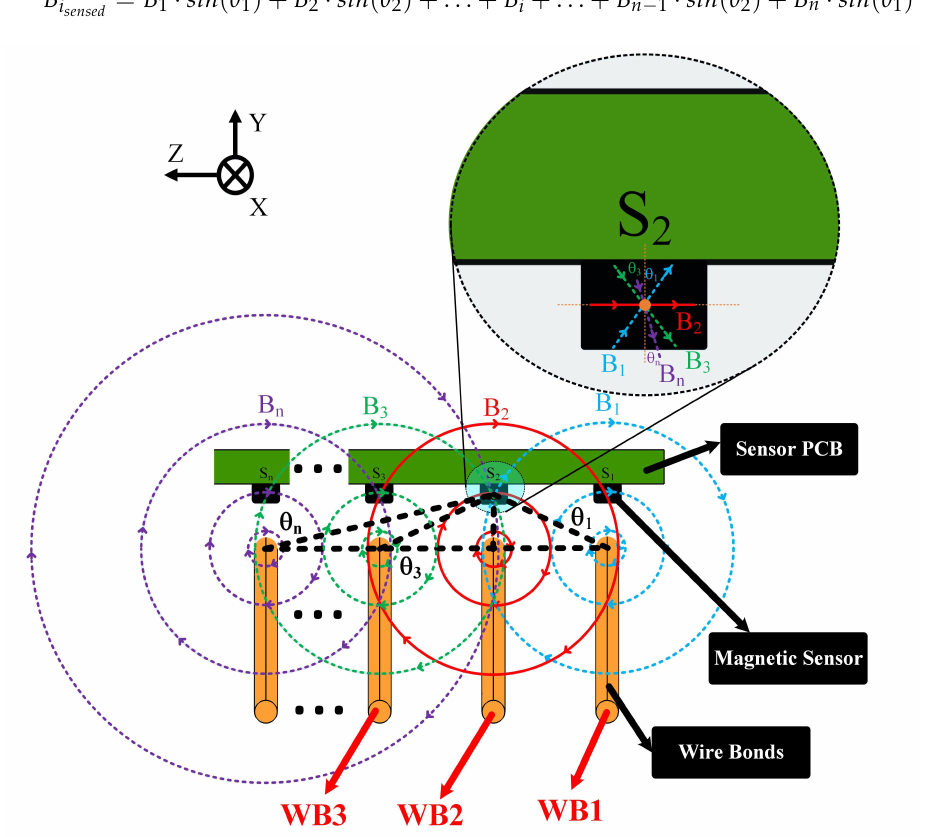
Figure 3. Mutual effect of the adjacent WBs in the sensed magnetic field of WB2. In case of complete lift off of a WB, the corresponding sensor of that specific WB shows the sensed magnetic field of the adjacent